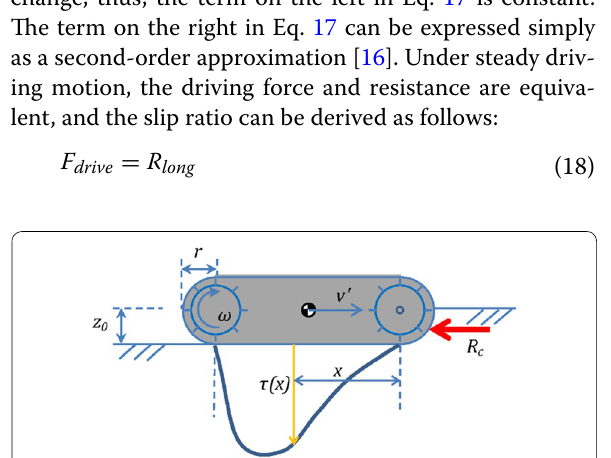
Fig. 4 Shear displacement under the